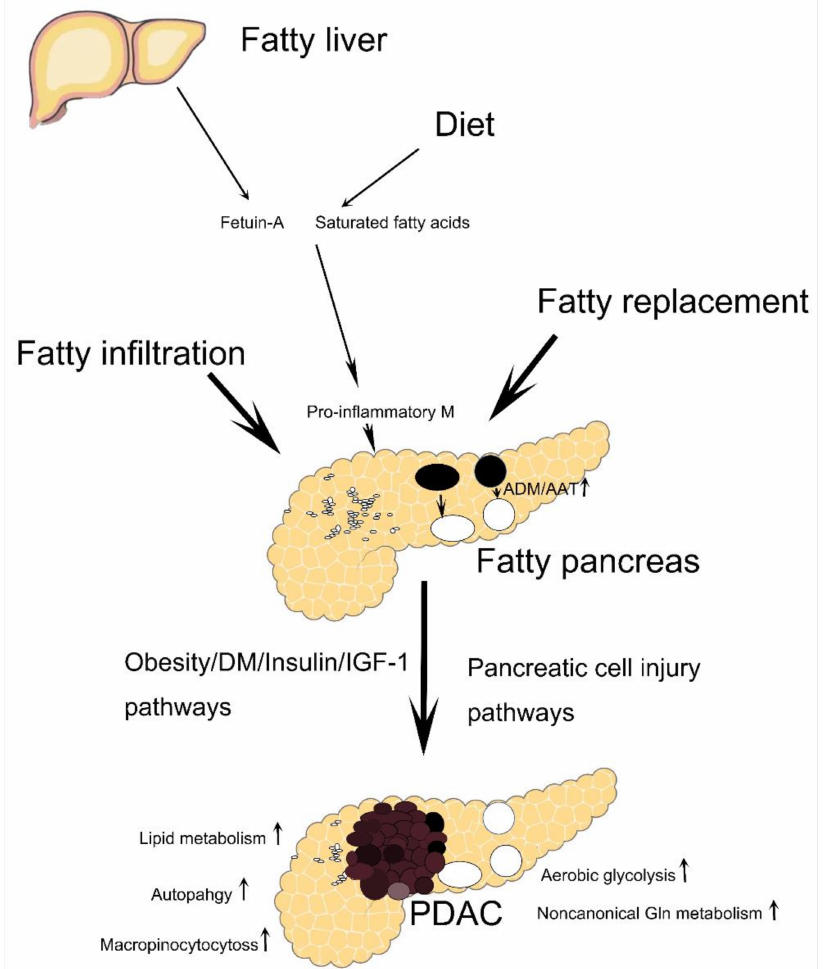
Figure 1. The proposed link between fatty pancreas and pancreatic ductal adenocarcinoma (PDAC). Fatty liver-derived fetuin-A and saturated fatty acids such as palmitate stimulate pancreatic fat cells and islet resident macrophages. Specifically, both fetuin-A and palmitate augment toll-like receptor 4 expression in pancreatic adipocytes, which in turn increase the secretion of interleukin-6,